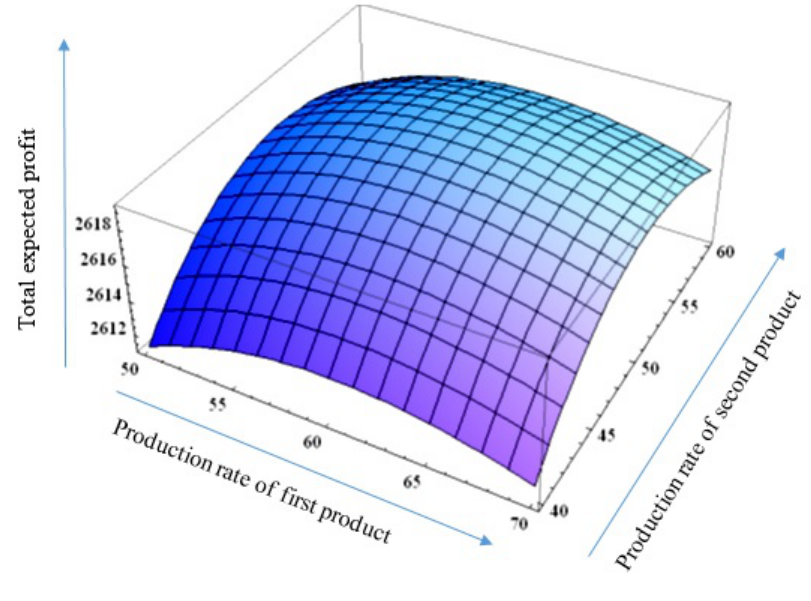
Figure 3. The total expected profit versus the production rate of two products ( P 1 , P 2 )